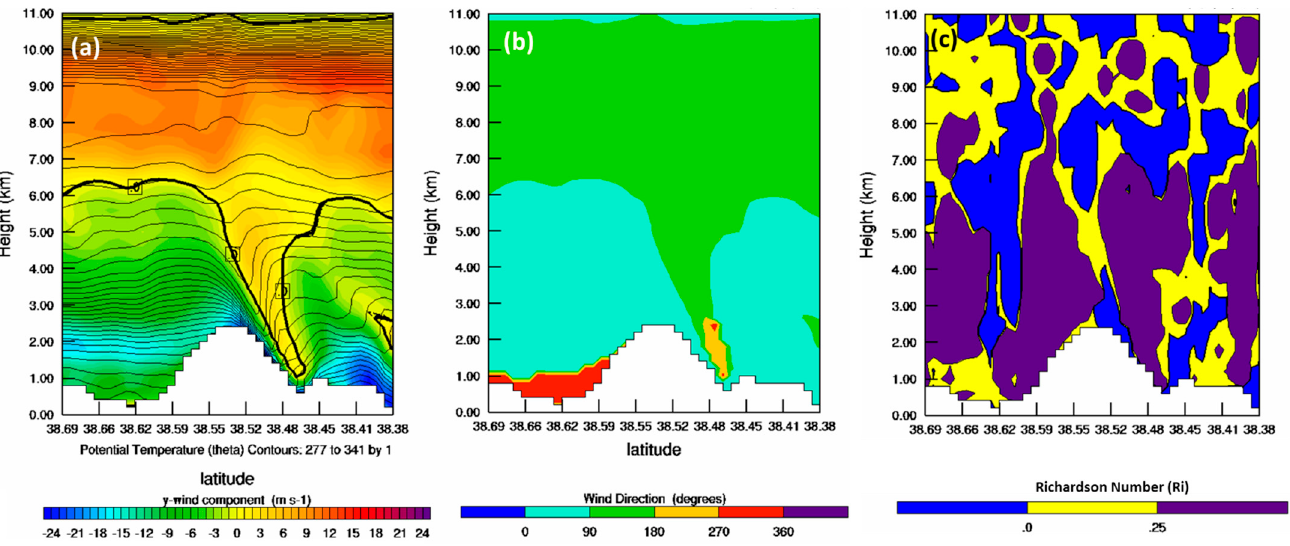
Figure 6. ( a ) Potential temperature (line contours in K) and meridional wind speed (color scale in m s − 1 ). The bold black line is the zero speed isotach; ( b ) Wind direction (degrees), ( c ) Richardson Number (R i ), simulated on 13 February 2019, 21:00 UTC.